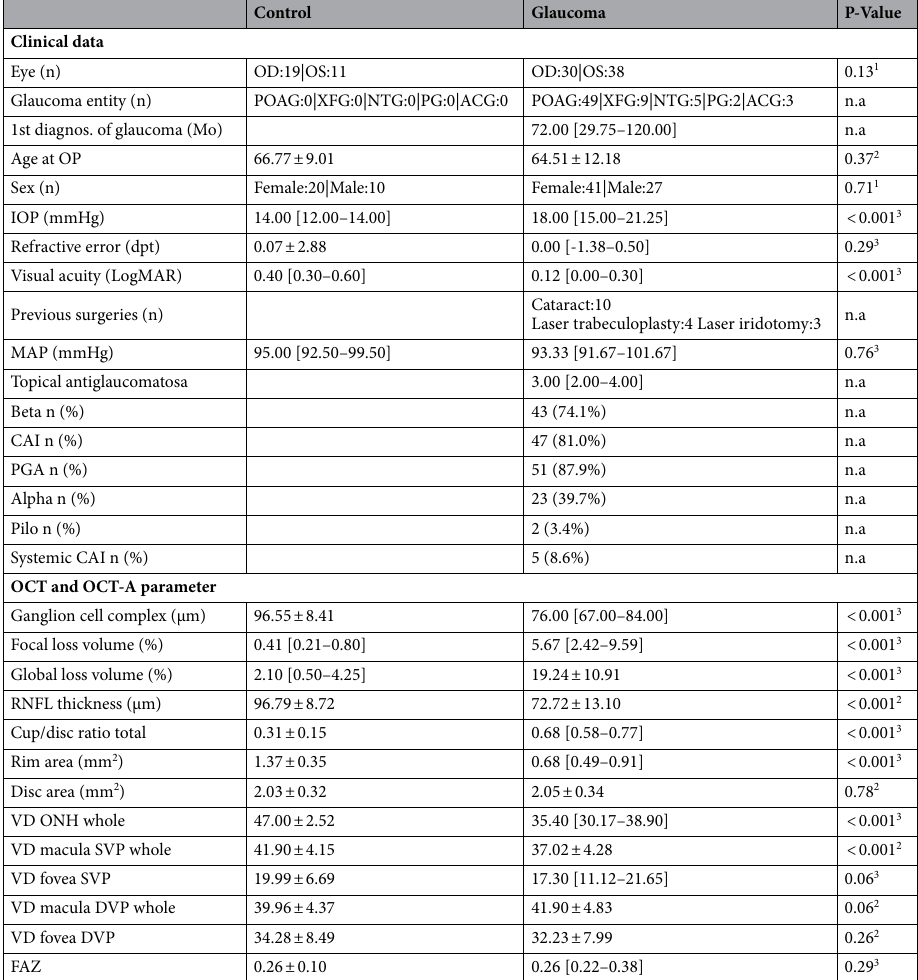
Table 1. Clinical data and OCT/OCT-A parameters. n.a. not applicable, POAG primary open-angle glaucoma, XFG exfoliative glaucoma, NTG normal-tension glaucoma, PG pigmentary glaucoma, ACG